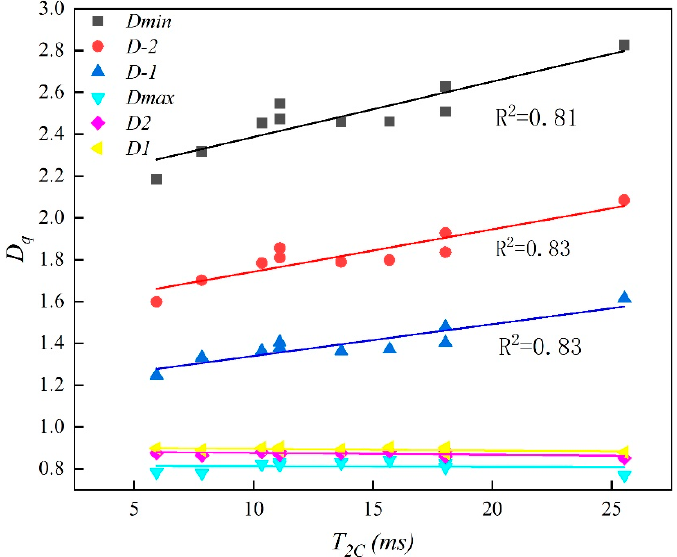
Figure 11. Relationship between T 2C and multifractal dimension ( D q ) of the ten modeling samples. Note that q was chosen as − 10, − 2, − 1, 1, 2, and 10.